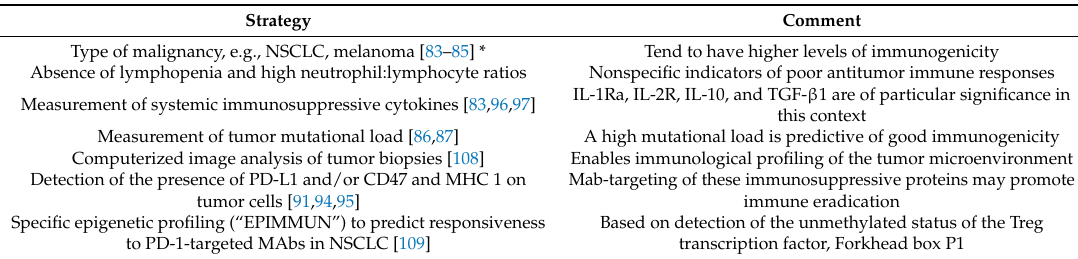
Table 3. Strategies which may assist in identifying those cancer patients who are most likely to benefit from